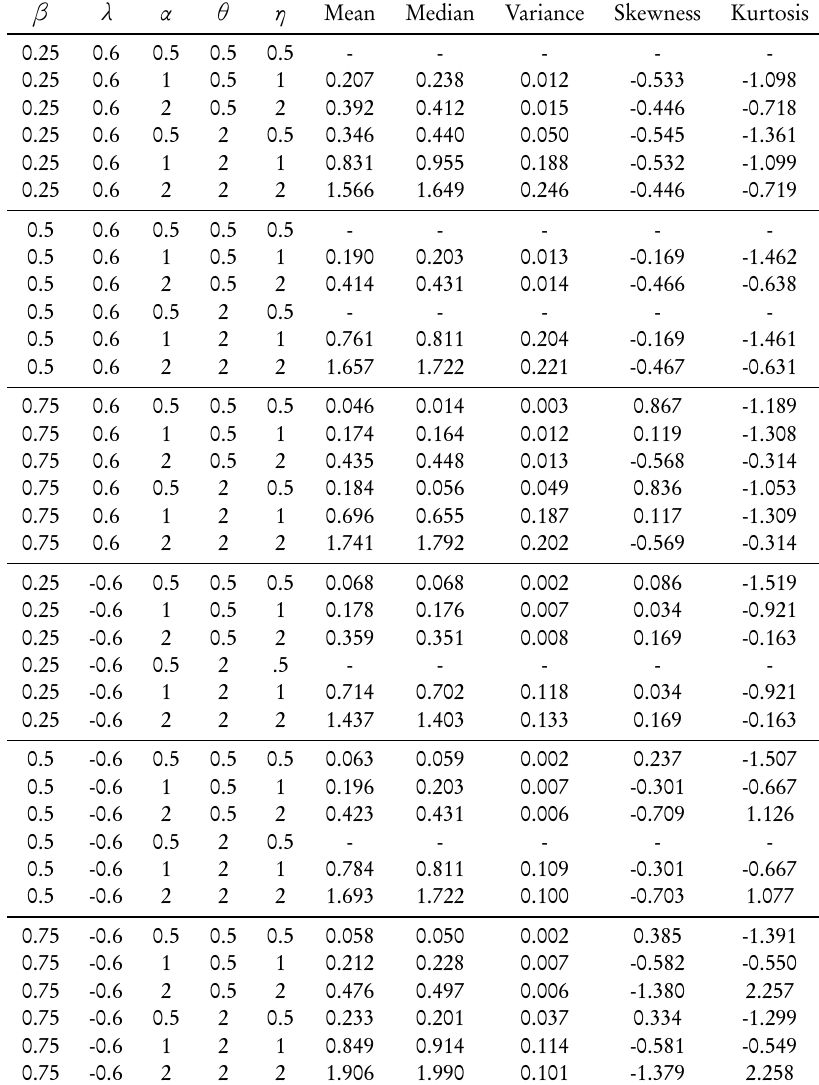
The mean, median, variance, skewness and kurtosis of the GOTTS-E distribution for some parameter